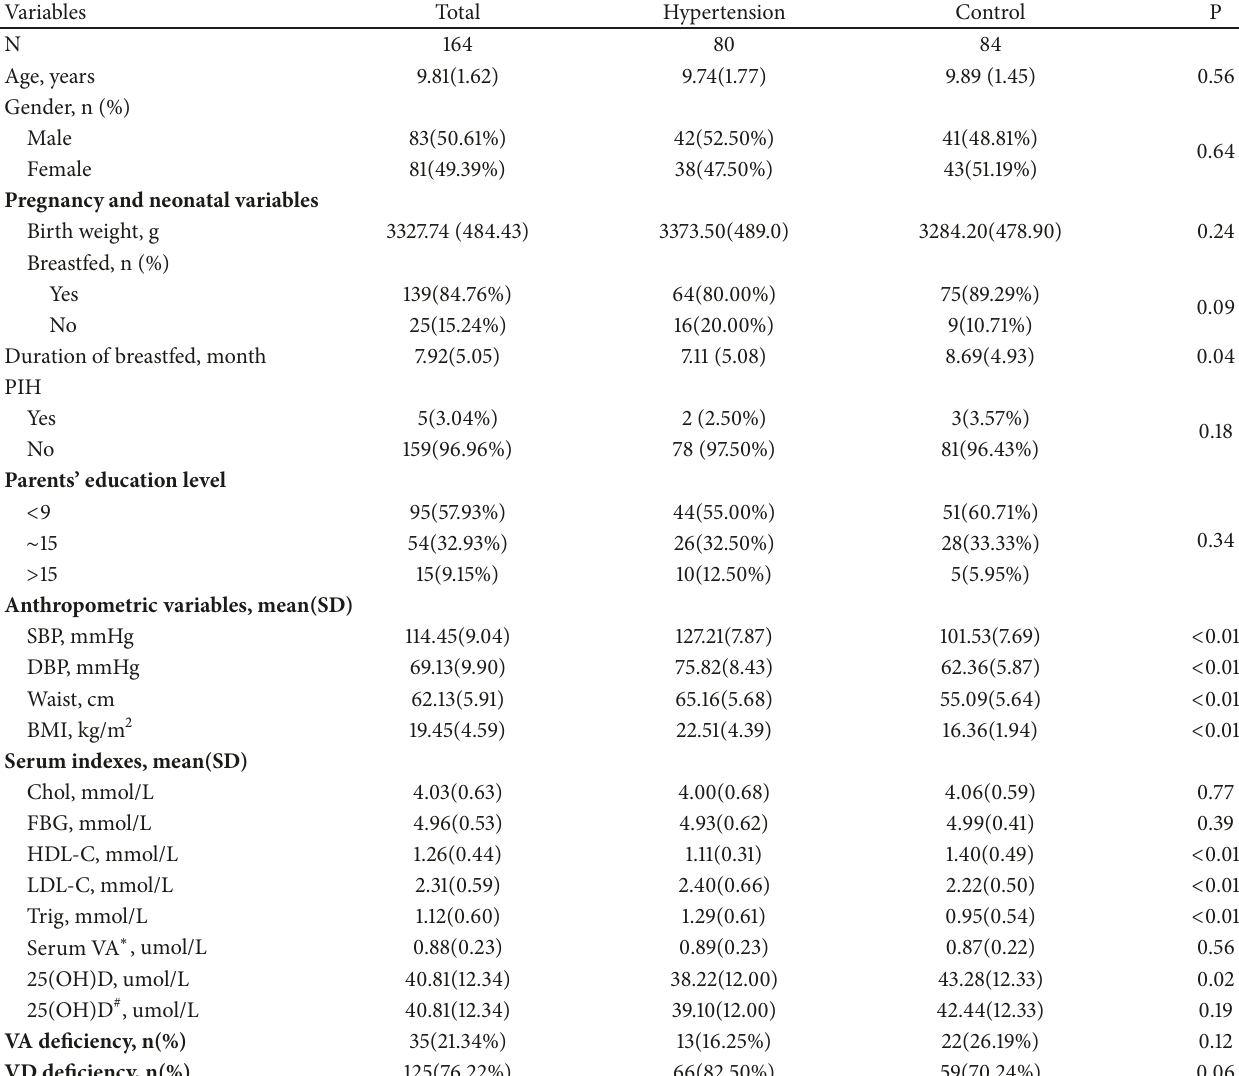
Table 1: Demographic information in the hypertensive group and the control group.